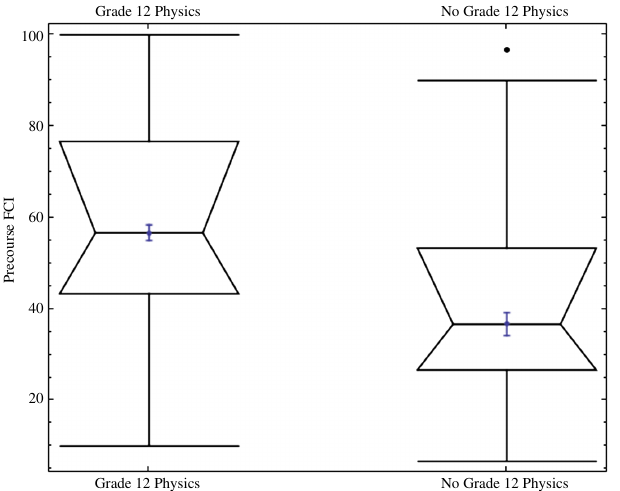
FIG. 5. Precourse FCI scores for students with and without senior level high school physics.